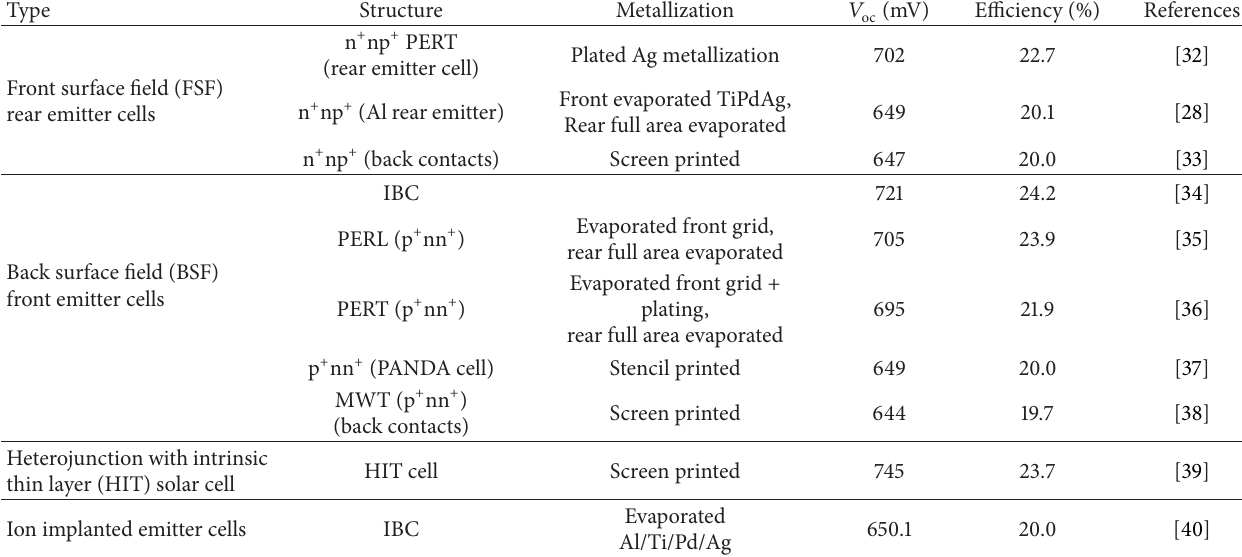
Table 1: Best results for various n-type high efficiency cell